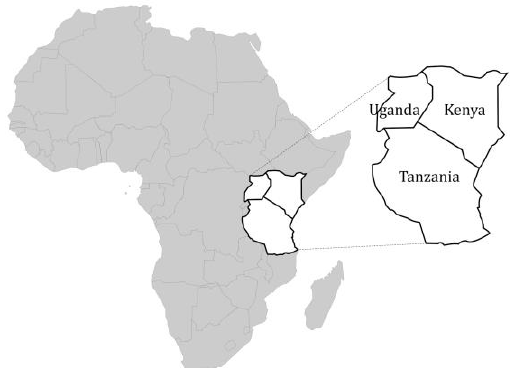
Figure 1. Area of interest in developing countries: Kenya, Uganda and